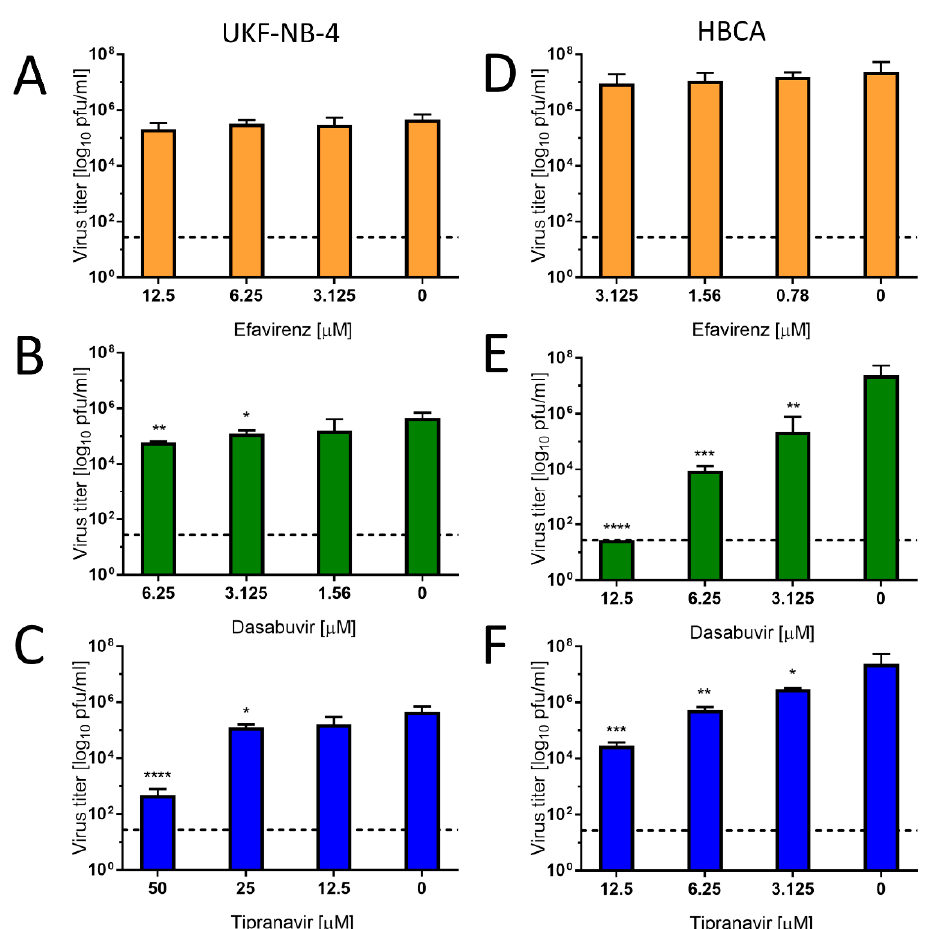
Figure 6. Inhibitory e ff ect of efavirenz, tipranavir, and dasabuvir against ZIKV, strain Paraiba_01 in UKF-NB-4 ( A , B , and C ) and HBCA ( C , D , and E ) cells using a pretreatment assay. The cells were treated with serial dilutions of the drugs. The highest drug concentration represented the highest non-toxic concentrations for the particular cell type. Culture supernatants were collected at 48 h p.i., and the viral titers were determined by plaque assay. Horizontal dashed lines indicate the minimum detectable threshold of 1.44 log 10 pfu / mL. Data were analyzed using Student’s t -test (GraphPad Prism, version 7.04); *, p < 0.05; **, p < 0.01; ***, p < 0.001; ****, p < 0.0001.